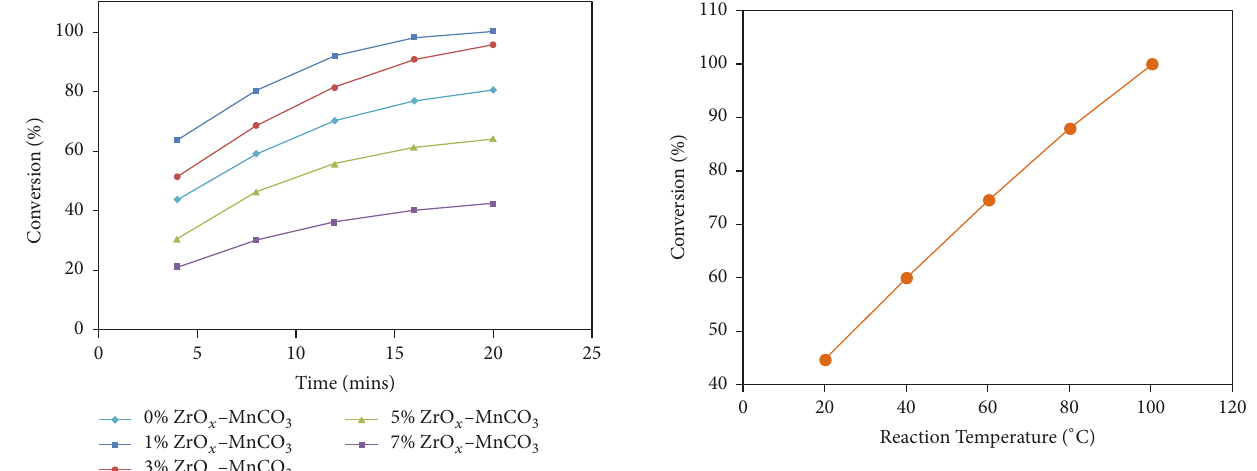
–MnCO 3 catalyst as a x